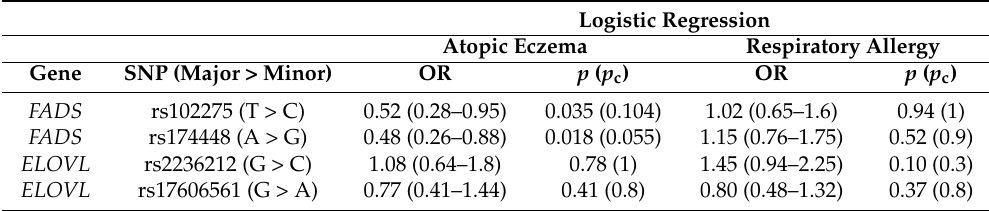
Table 7. Association between FADS and ELOVL genes and atopic eczema and respiratory